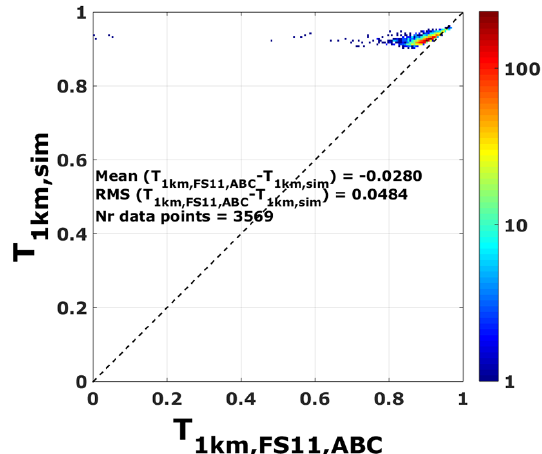
Figure 9. Modeled transmittance for 1km slant range compared with absorption- and broadband-corrected transmittance as in case of Sect. 3.1 measured by FS11 scatterometer. Color distribution dis- plays the number of data points per grid point (logarithmic color scale).